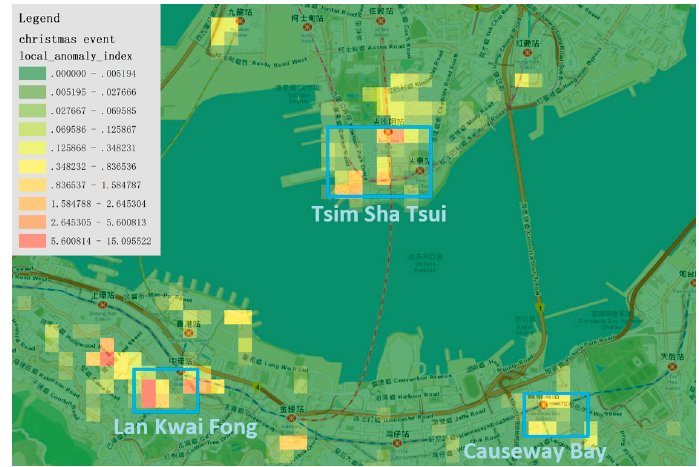
Figure 11. The 𝐿𝐸𝐼 values across the Hong Kong urban area, calculated from the ‘Christmas’ check-ins. The high-value regions are mainly in Tsim Sha Tsui, Lan Kwai Fong and Causeway Bay, which are all major recreational regions in Hong Kong.